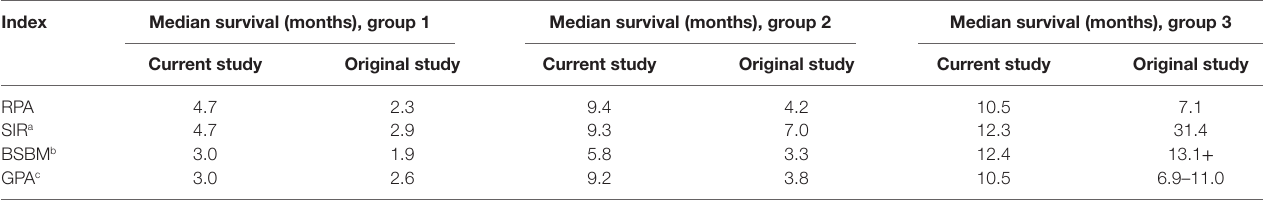
TaBle 3 | comparison of median survivals between this study and original studies for each